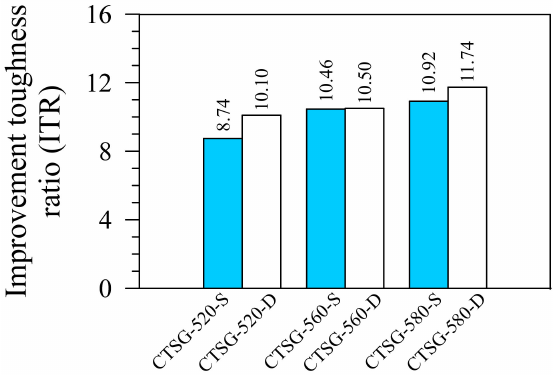
Figure 10. Improvement toughness ratios.